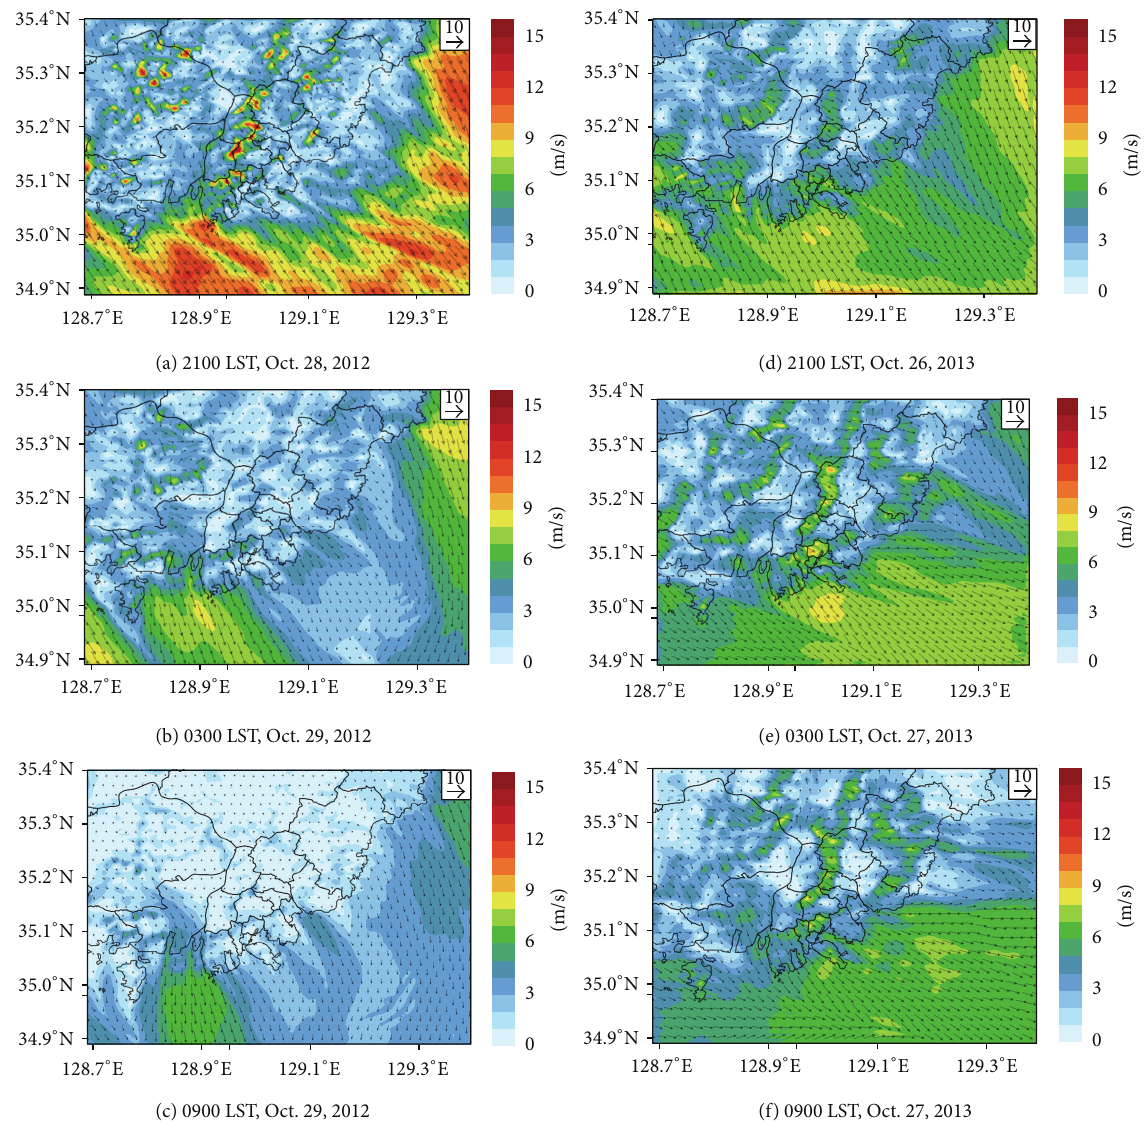
Figure 5: Surface wind field at 10 m AGL distribution simulated by the WRF model in the evening (21:00 LST) of the BFF event day, early morning (03:00 LST), and morning (09:00 LST) of the next day in